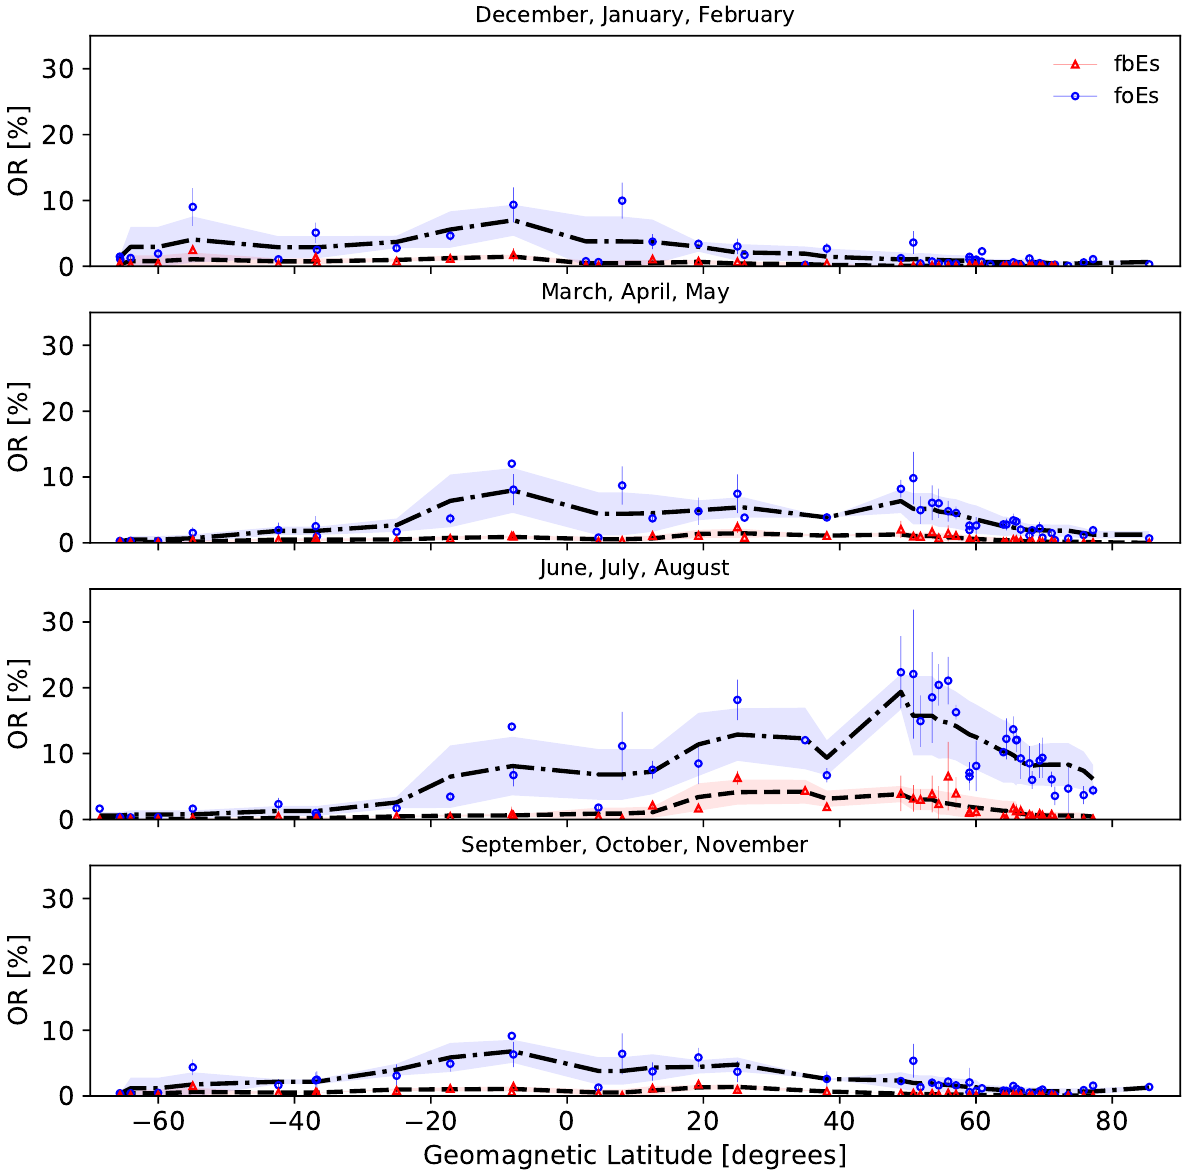
Figure 8. Occurrence rates for fbEs and foEs ≥ 5 MHz separated by geomagnetic latitude. Error bars correspond to the standard deviation of the yearly averages taken over all years with sufficient data. The trend lines and shading correspond to spatial running averages and standard deviations calculated with a ± 10 ◦ window,